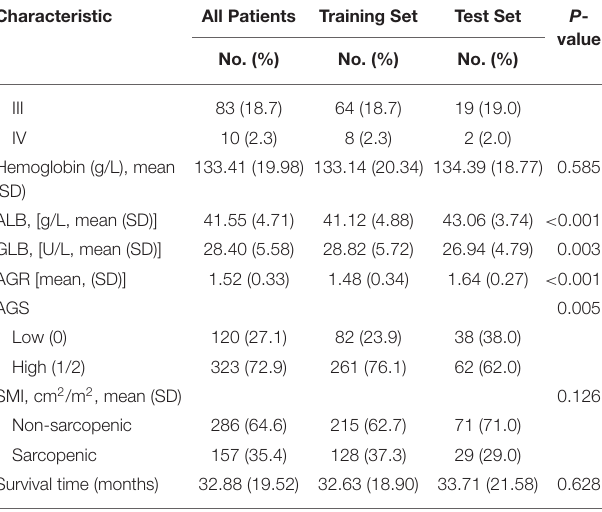
TABLE 1 | Baseline characteristics of patients in the training and test